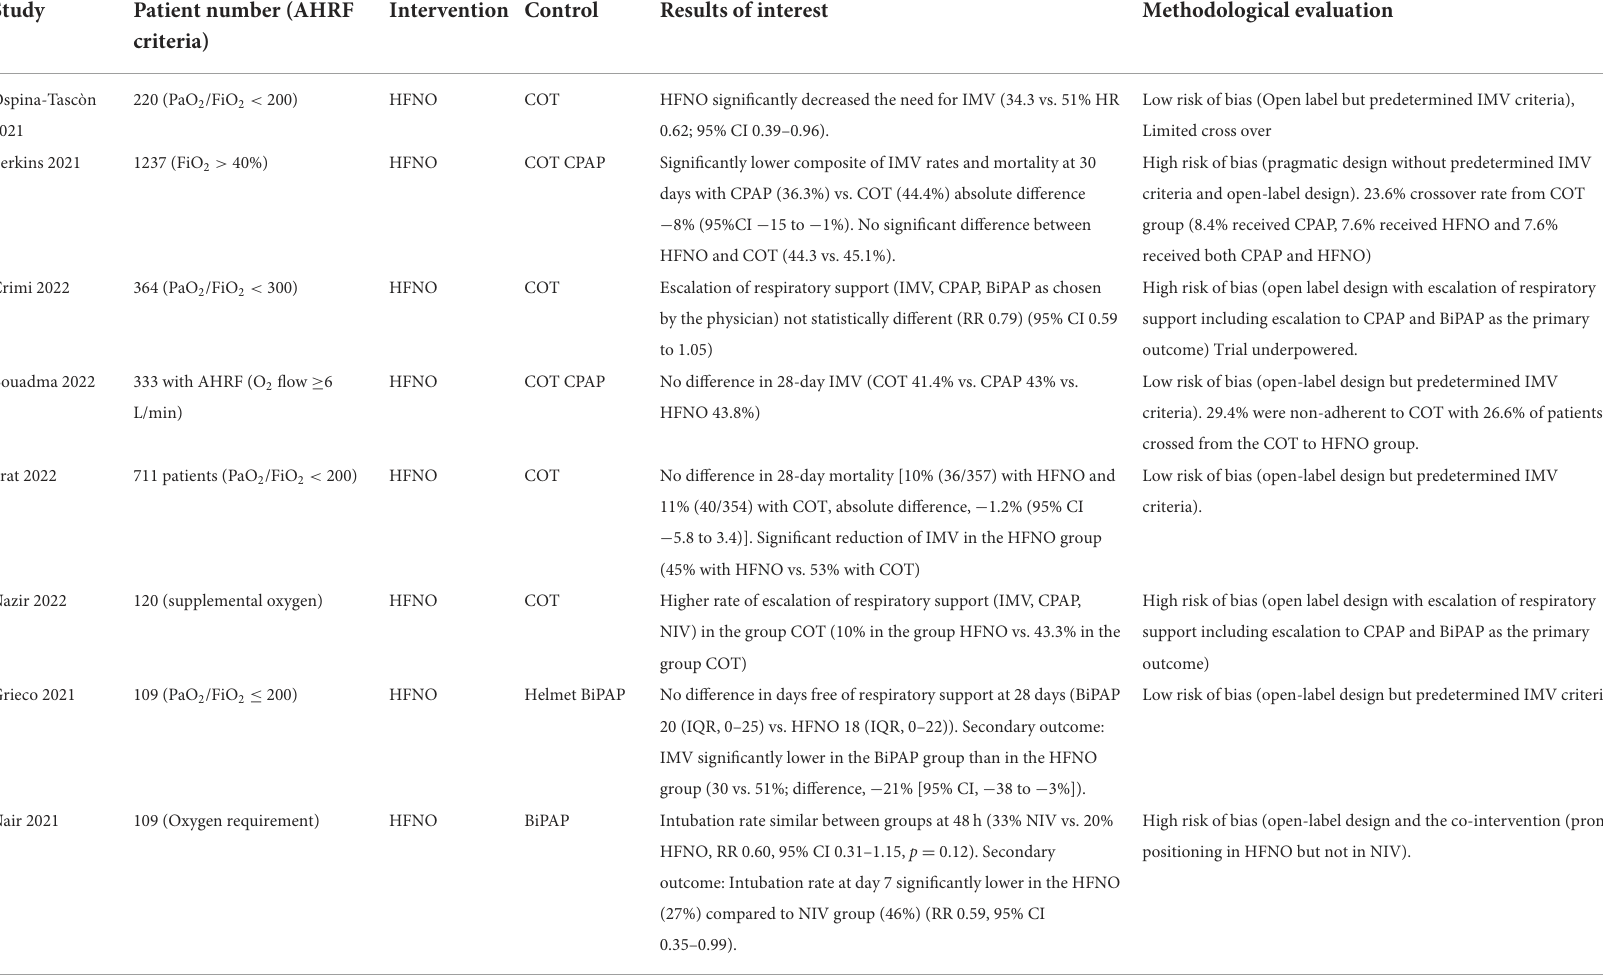
TABLE 5 Randomized controlled trials comparing high-flow nasal oxygen, non-invasive ventilation, and conventional oxygen therapy in COVID-19-related acute hypoxemic respiratory